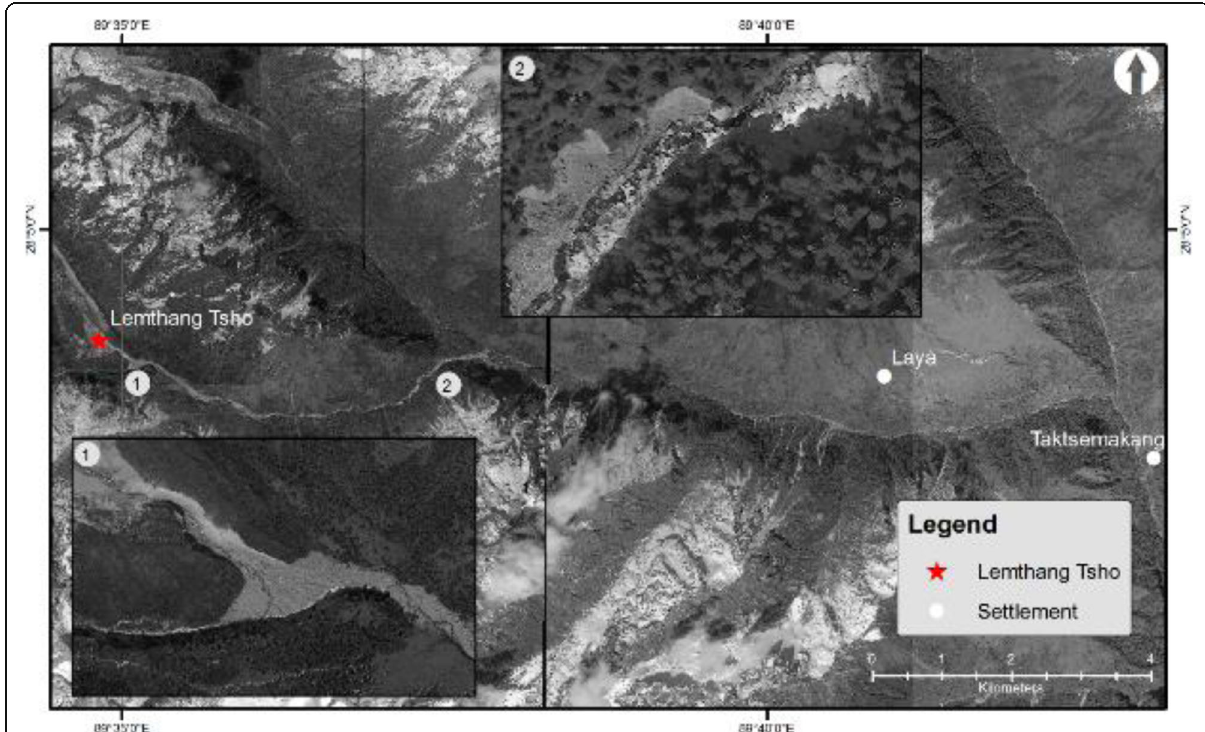
Fig. 9 Map showing deposition and erosion areas in the vicinity of the lake. Background image is WV-01 (50 cm resolution) dated